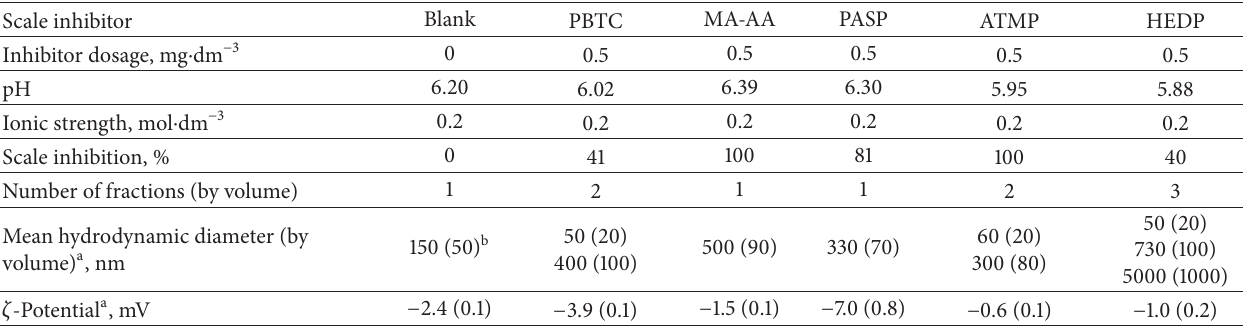
Table 4: DLS calcium sulfate particles characterization in an aqueous phase at 25 ∘ C directly after cooling of a supersaturated gypsum